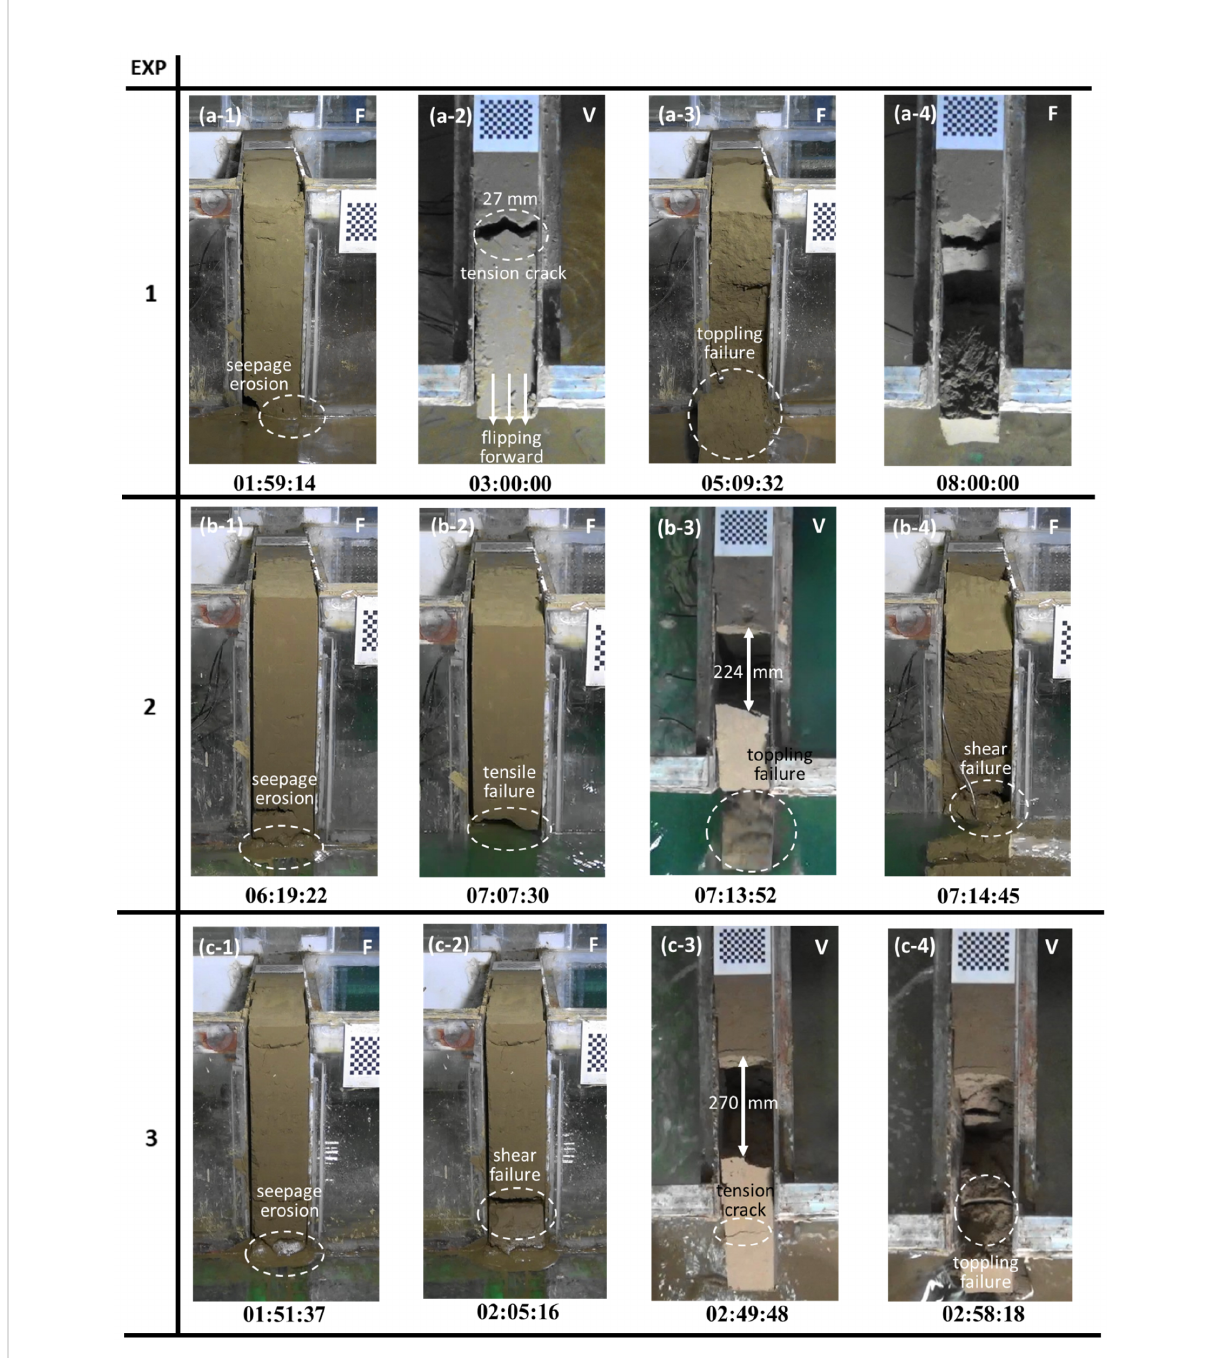
FIGURE 3 Photos of bank pro fi le evolution during each 2D experiment: (A) EXP 1: Hs = 60 cm, Ts = 7 h, Hw = 15 cm, Tw = 1 h; (B) EXP 2: Hs = 30 cm, Ts = 7 h, Hw = 15 cm, Tw = 1 h; (C) EXP 3: Hs = 60 cm, Ts = 3h. F, front view; V, vertical